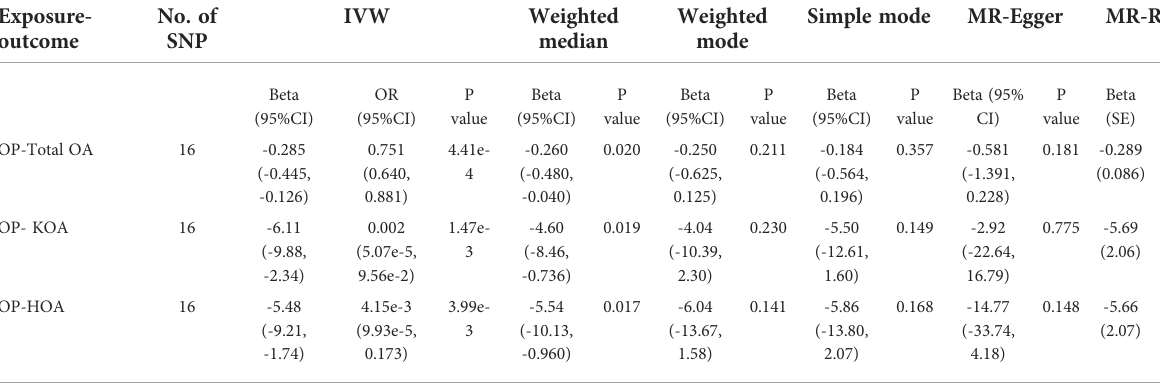
TABLE 1 MR estimates from different methods of assessing the causal effect of osteoporosis on osteoarthritis. Exposure-